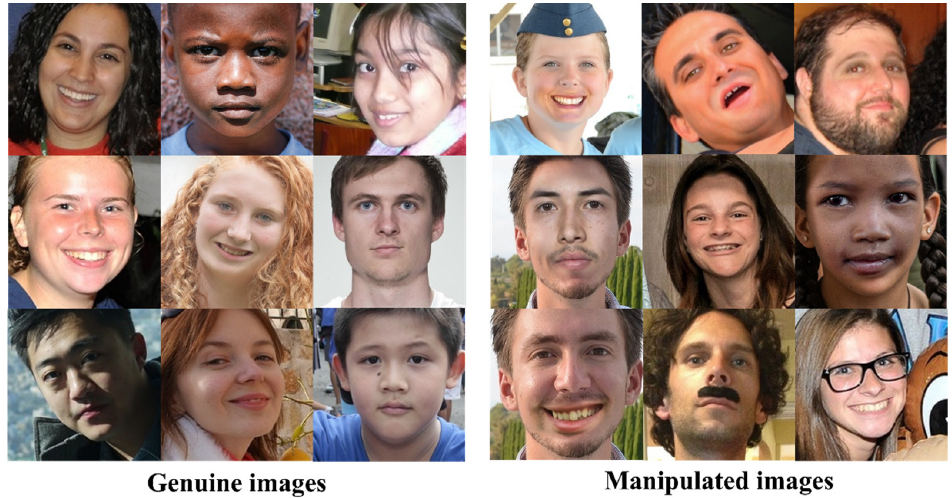
Figure 2. Examples of genuine face images ( left ) and manipulated face images ( right ) generated from the collected genuine face images.